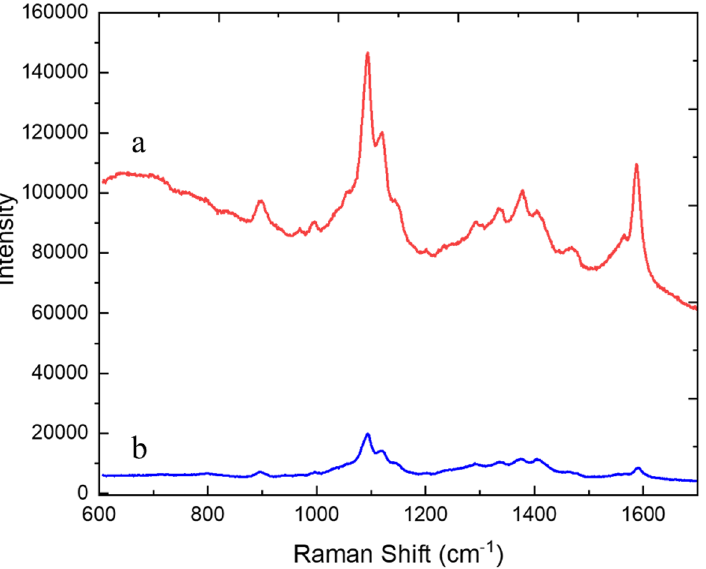
Figure 3. Raman spectra of TEMPO-CNFs after heated in 150 °C saturated water vapor for 4 h (a) or the as-produced TEMPO-CNFs (b). The excitation wavelength was 532 nm, exposure time 10 s, and laser power